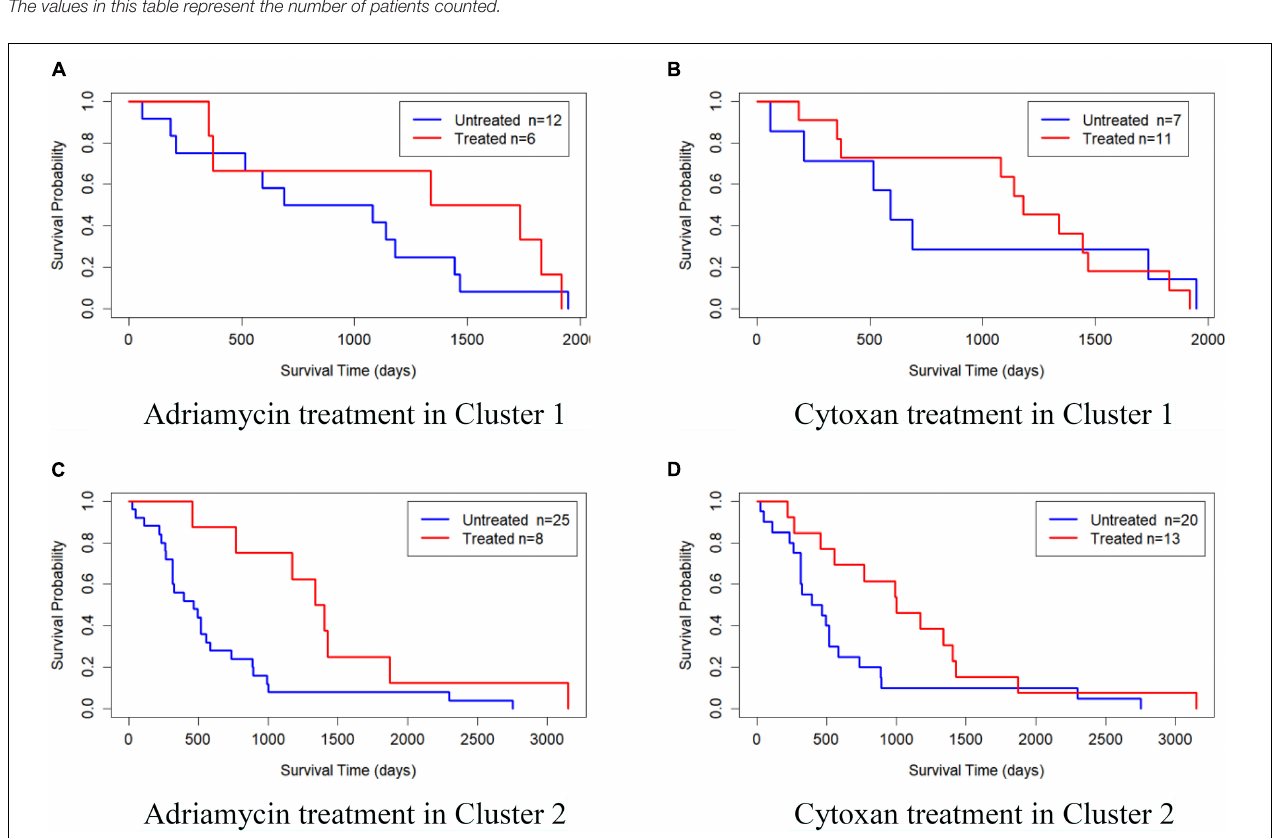
FIGURE 5 | Kaplan–Meier survival curves of drug response in Cluster 1 and Cluster 2. (A) Adriamycin treatment in Cluster 1, (B) Cytoxan treatment in Cluster 1, (C) Adriamycin treatment in Cluster 2, and (D) Cytoxan treatment in Cluster